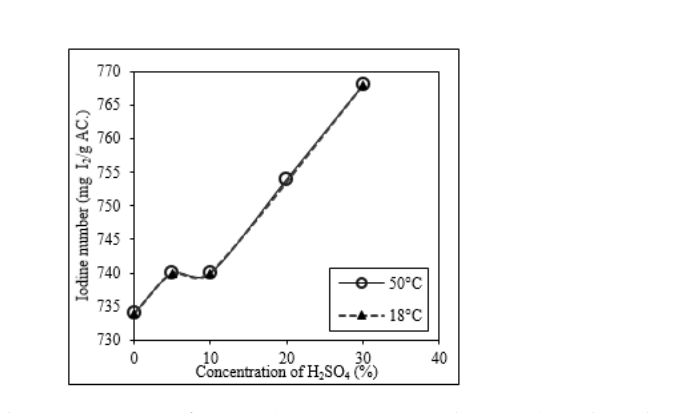
Figure A1. Influence of the concentration of H 2 SO 4 (5%, 10%, 20%, and 30% v / v ) on the iodine number (mg I 2 /g AC) of SAC subjected to chemical reactivation at 18 °C and 50 °C.